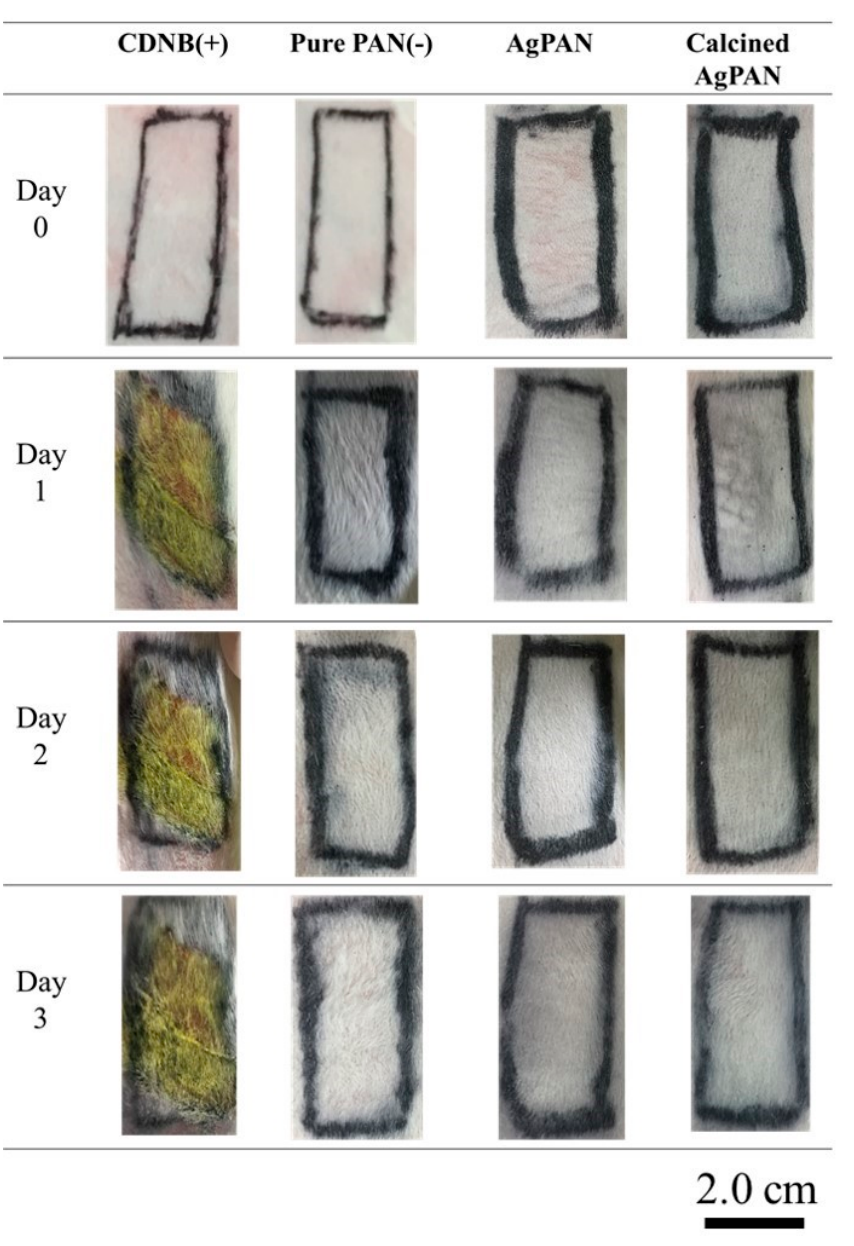
Figure 6. Testing for sensitivity of animal skin to various types of nonwoven mats for 3 days.